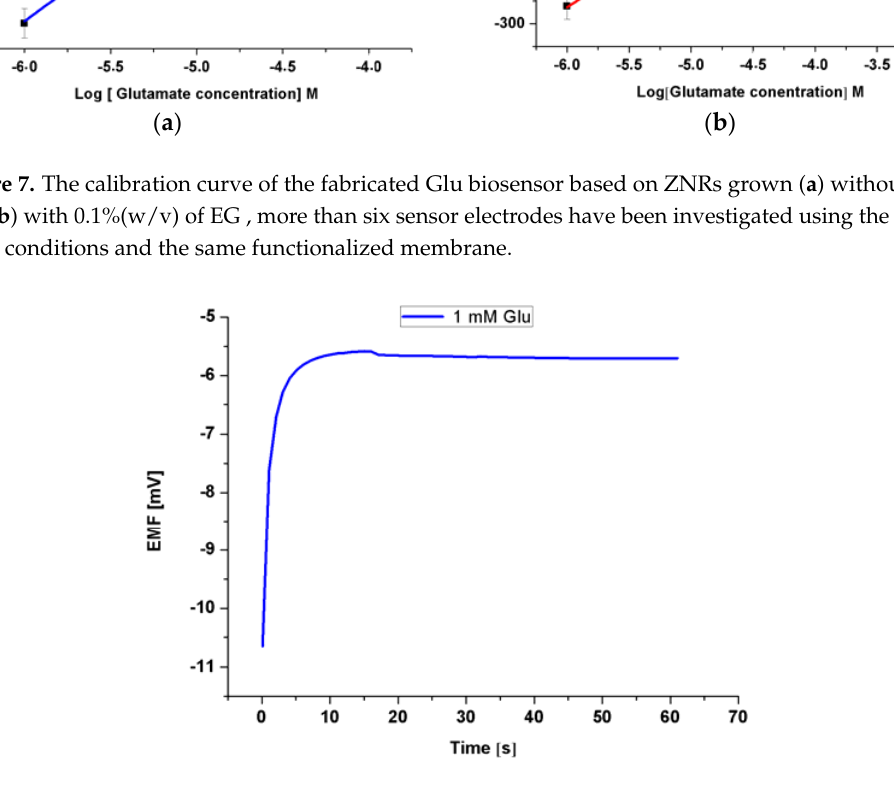
Figure 8. Response time of less than 10 s measured in 1 mM concentration of Glu.